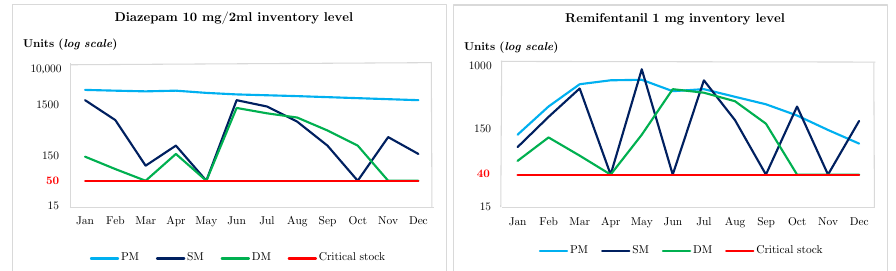
Figure 4. Inventory levels, during 2018, for two example drugs (Diazepam 10 mg/2 mL and Remifentanil 1 mg, in units). Table 4. Attribute evaluation and comparison of both